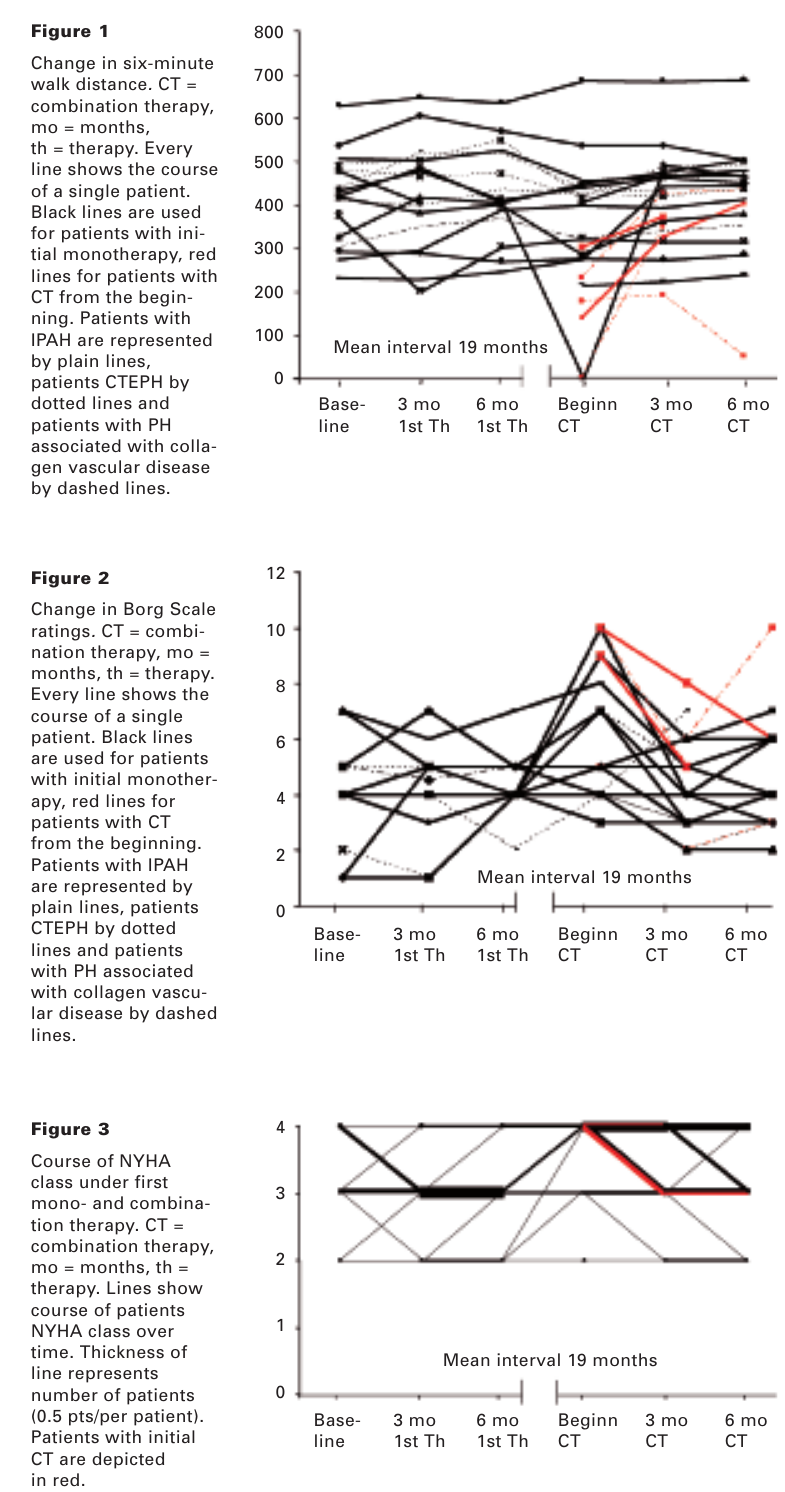
Course of NYHA class under first mono- and combina- tion therapy. CT = combination therapy, mo = months, th = therapy. Lines show course of patients NYHA class over time. Thickness of line represents number of patients (0.5 pts/per patient). Patients with initial CT are depicted in